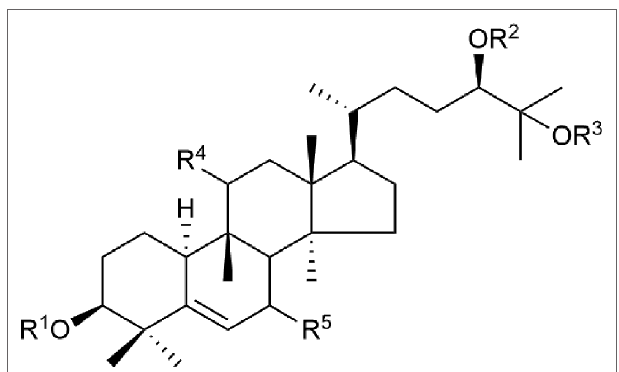
FIGURe 2 | The skeletal structures of triterpenoid from S. grosvenorii